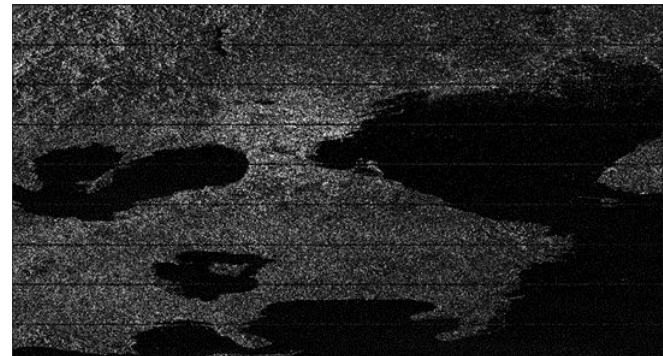
Figure 2. Sample SLC SAR Image